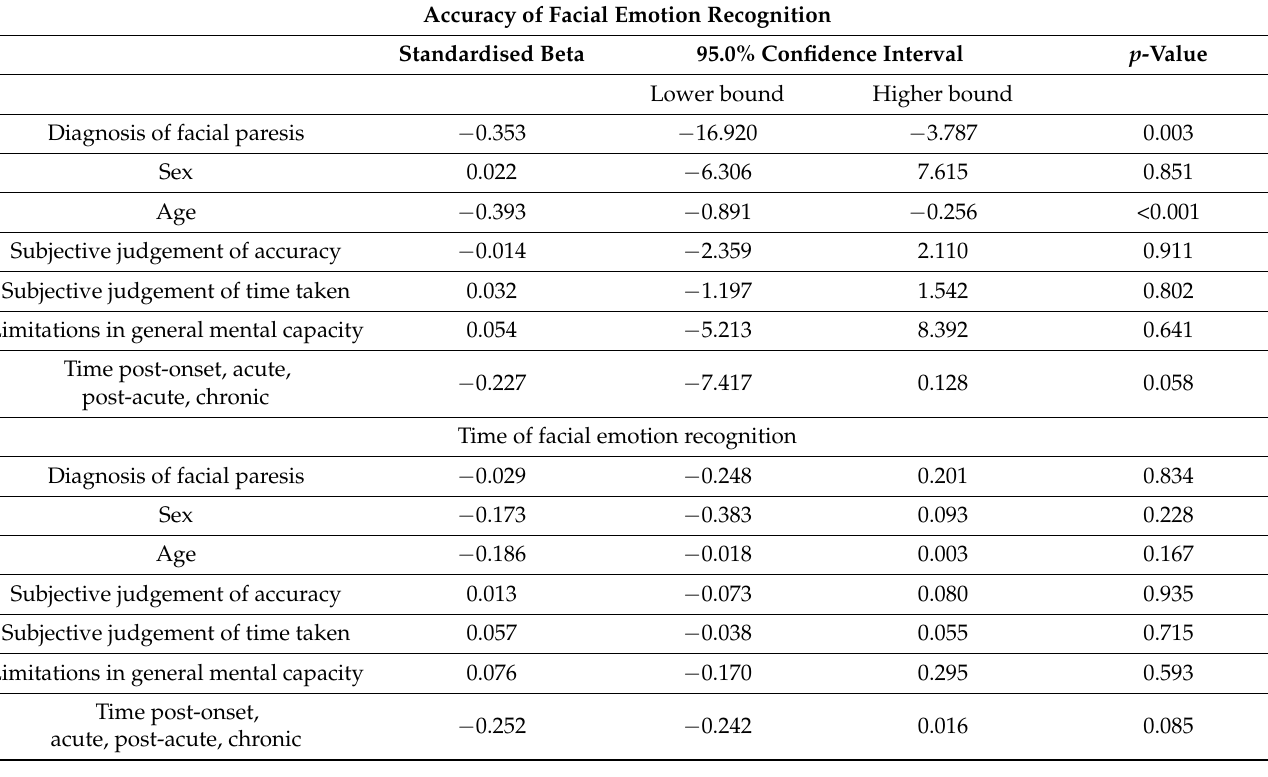
Table A8. Multivariate regression analysis.